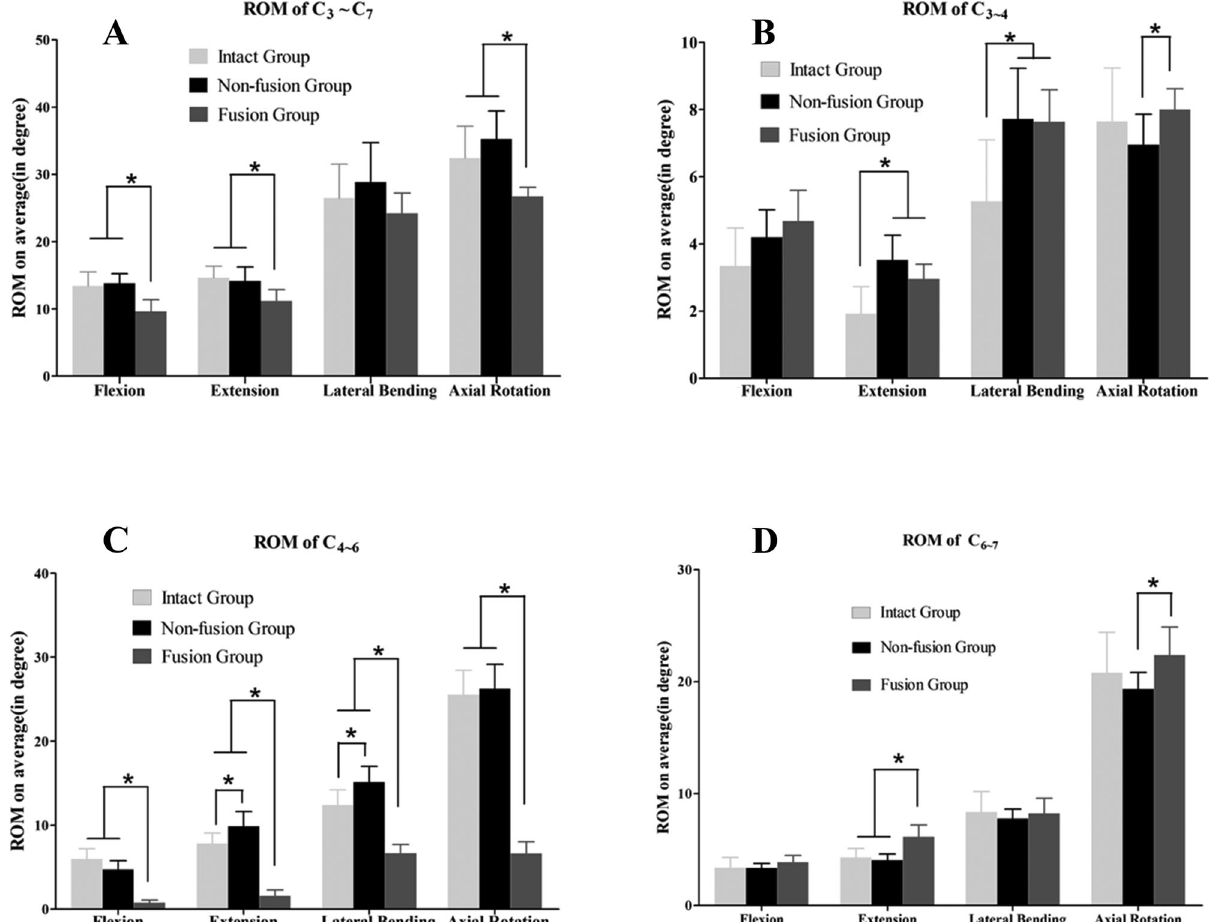
Figure 2 - ROM of C3 B C7, C3 B 4, C4 B 6, C6 B 7. The ROM were measured under 2 N (cid:1) m torque loading pressure. A) the fusion group showed a significantly restricted ROM of C3 B C7 regarding flexion, extension and axial rotation ROM of C3 B C7 compared to the intact group and non-fusion group. No significant difference of ROM in any direction was detected when compared the intact group and non-fusion group. B) the fusion group and non-fusion group showed a significantly increased ROM of C3 B 4 regarding extension and lateral bending ROM of C3 B 4 compared to the intact group. Significant difference of ROM of C3 B 4 in axial rotation was detected when compared the intact group and non-fusion group. C) the fusion group showed a significantly restricted ROM of C4 B 6 in all directions compared to the intact group and non-fusion group. Comparing with the intact group, the extension and lateral bending ROM of C4 B 6 in non-fusion group increased significantly. D) the fusion group showed a significantly restricted ROM of C6 B 7 in extension compared to the intact group and non-fusion group. The axial rotation ROM of C6 B 7 in non-fusion group decreased significantly comparing with the fusion group. No significant difference of ROM of C6 B 7 in any direction was detected when compared the intact group and non-fusion group. * p o